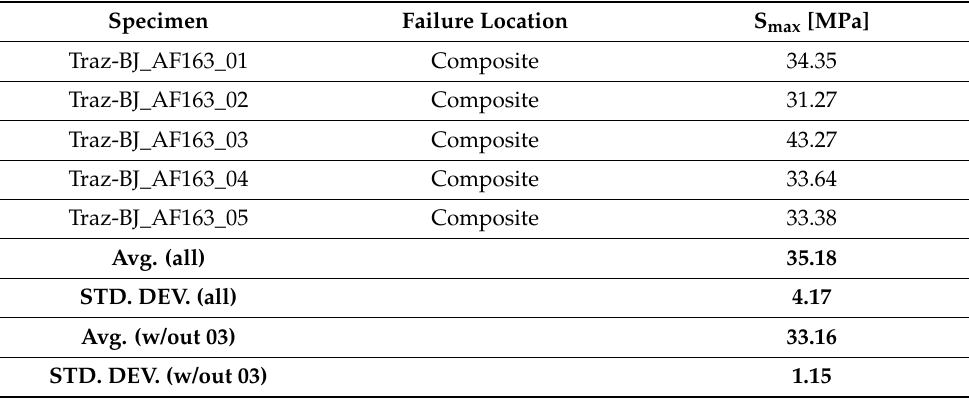
Figure 10. Force-displacement results of TRAZ-BJ_AF163 tests. Table 5. Failure location and tensile strength of TRAZ-BJ_AF163 tests.